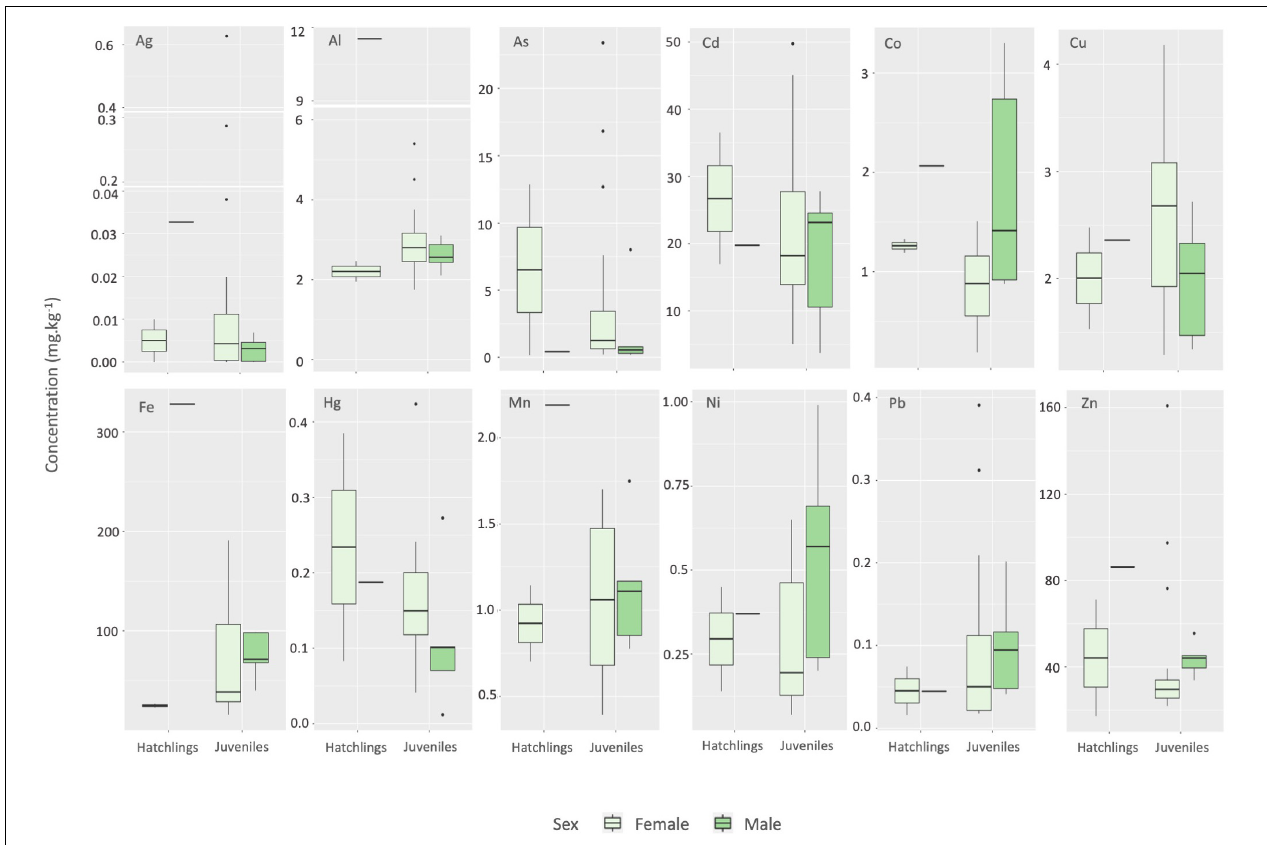
FIGURE 4 | Box plots representing elemental concentration variations in green turtle ( Chelonia mydas ) kidneys. Black dots indicate outliers, while white bars represent breaks in the y -axis. Light green columns represent females and dark green,